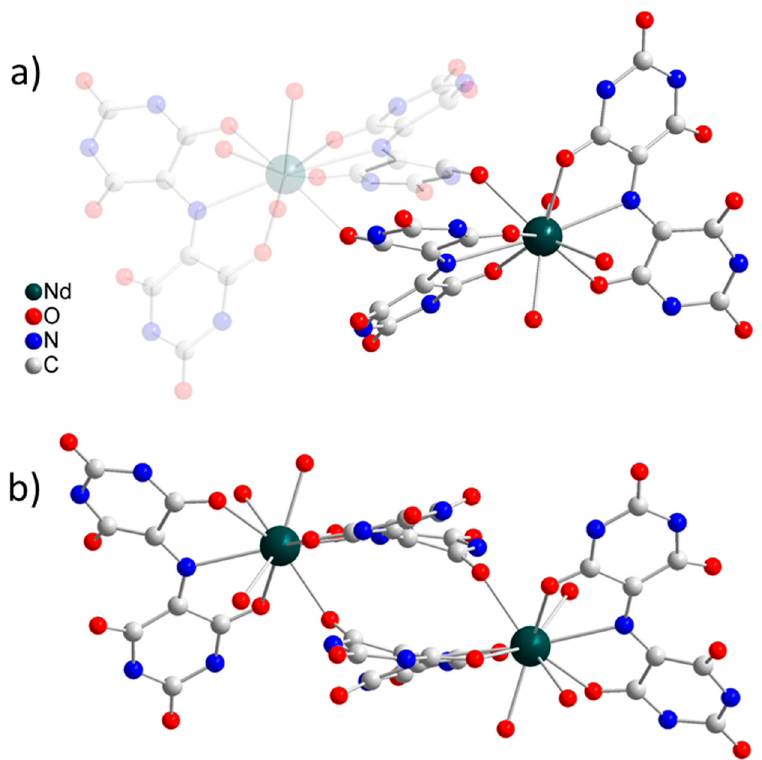
Figure 2. Best views of the NdMurex dimeric structure with ( a ) the asymmetric unit highlighted, and ( b ) a view parallel to the stacking of murexide ligands. Hydrogen atoms and water molecules are omitted for clarity.